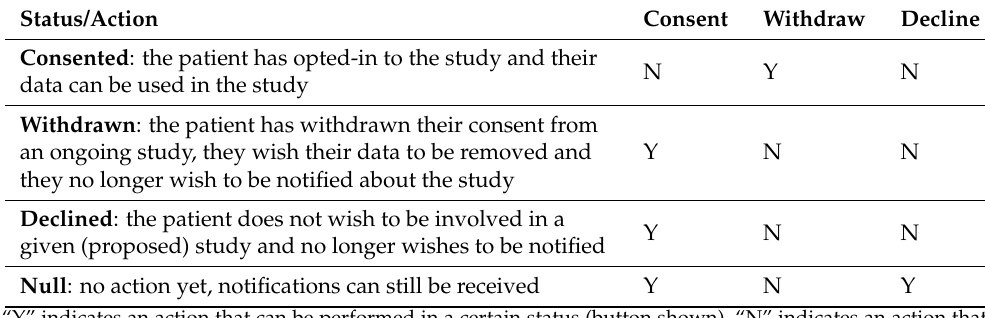
Table 1. Consent status and associated actions.